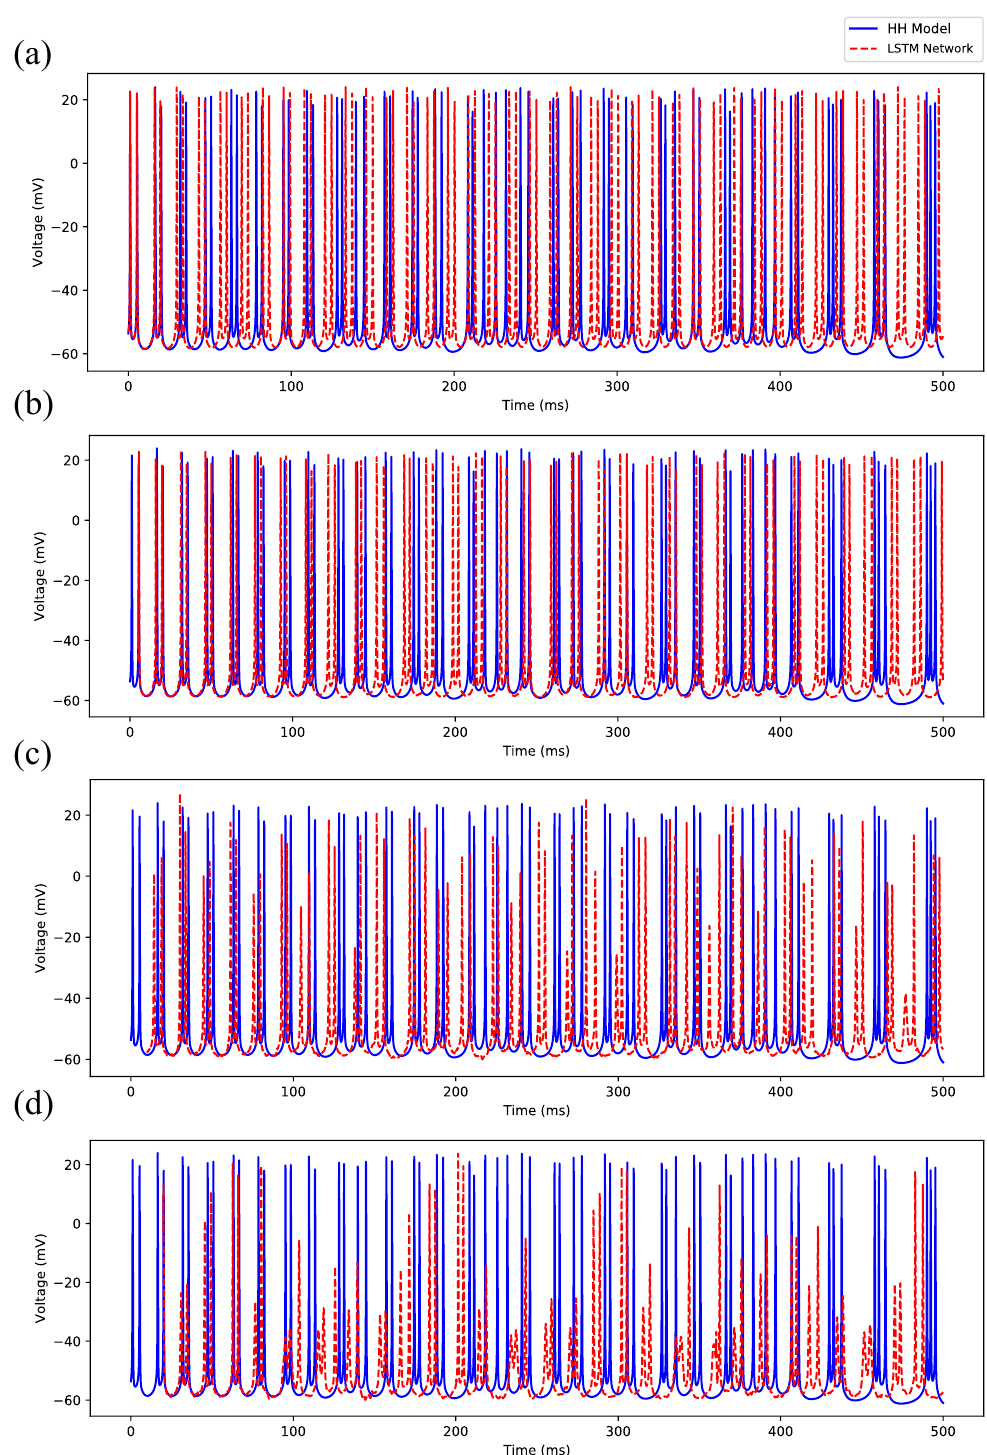
Figure 9. Comparison of predicted membrane potential traces by the deep LSTM neural network (“LSTM Network”) to the irregular bursting spiking patterns exhibited by the Hodgkin-Huxley model (“HH Model”) in response to the external stimulating current I = 1.5 nA. ( a ) Prediction using 1 timestep predictive LSTM network ( N p = 1). ( b ) Prediction using 50 timesteps predictive LSTM network ( N p = 50). ( c ) Prediction using 100 timesteps predictive LSTM network ( N p = 100). ( d ) Prediction using 200 timesteps predictive LSTM network ( N p =